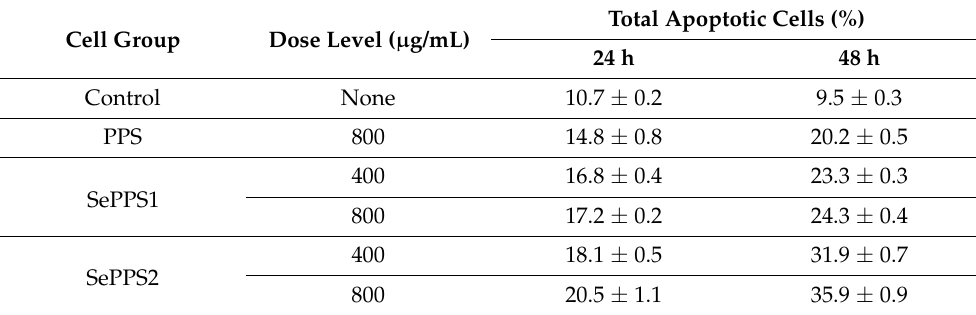
Table 4. Relative gene expression folds of HCT-116 cells treated with PPS, SePPS1, and SePPS2 for 24 h.